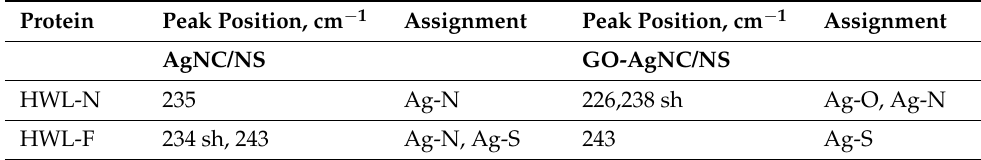
Table 3. Average position of SERS peaks in the 180–400 cm − 1 range.